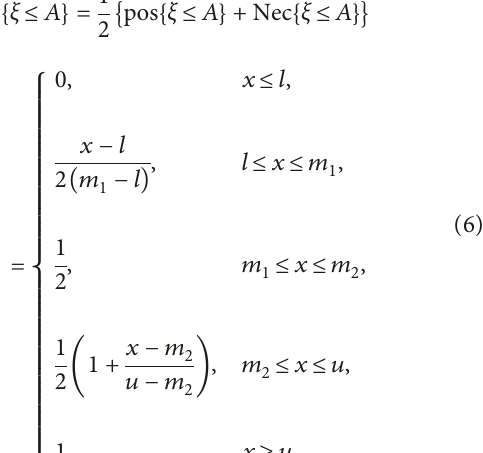
Figure 3: Credibility